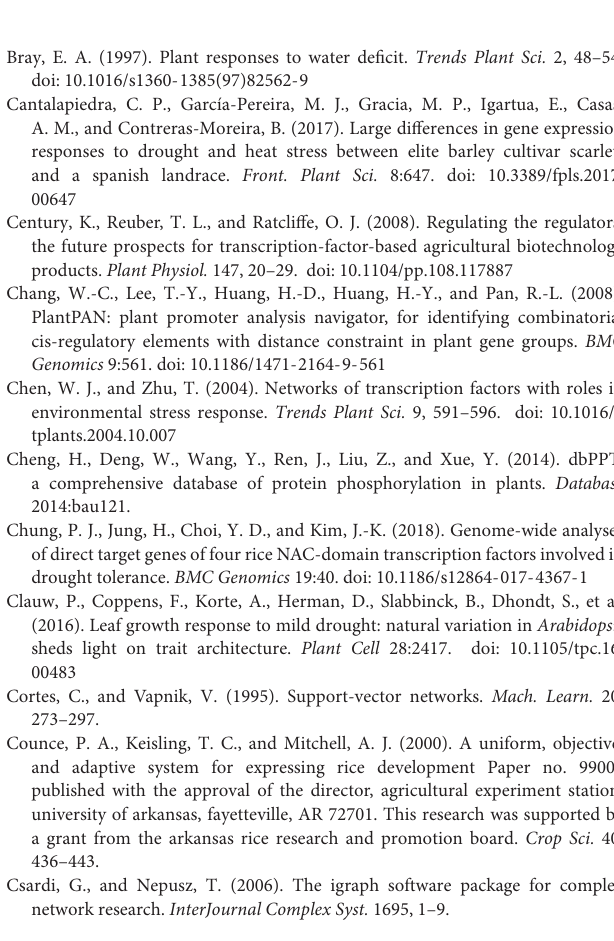
Supplementary Data 8 | OsbHLH148 differential expression test results. Supplementary Data 9 | GEO datasets used to build